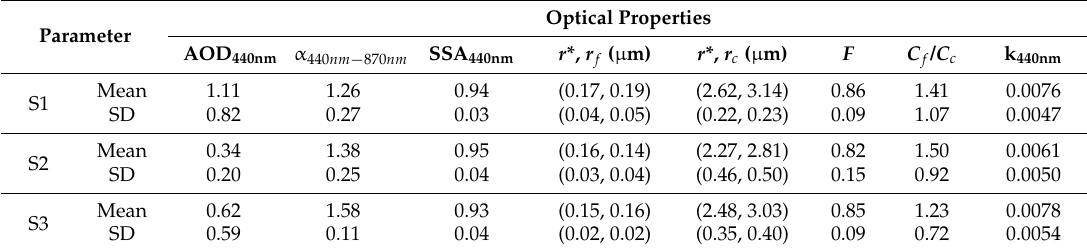
Figure 7. Variation of the imaginary part of the complex refractive index at different wavelengths. Table 1. Parameters of aerosol optical properties ( r * is effective radius; r is volume median radius, F is fine mode fraction; C f / C c is the ratio of fine mode volume concentration to coarse; k 440nm is the imaginary part of the complex refractive index at 440 nm).